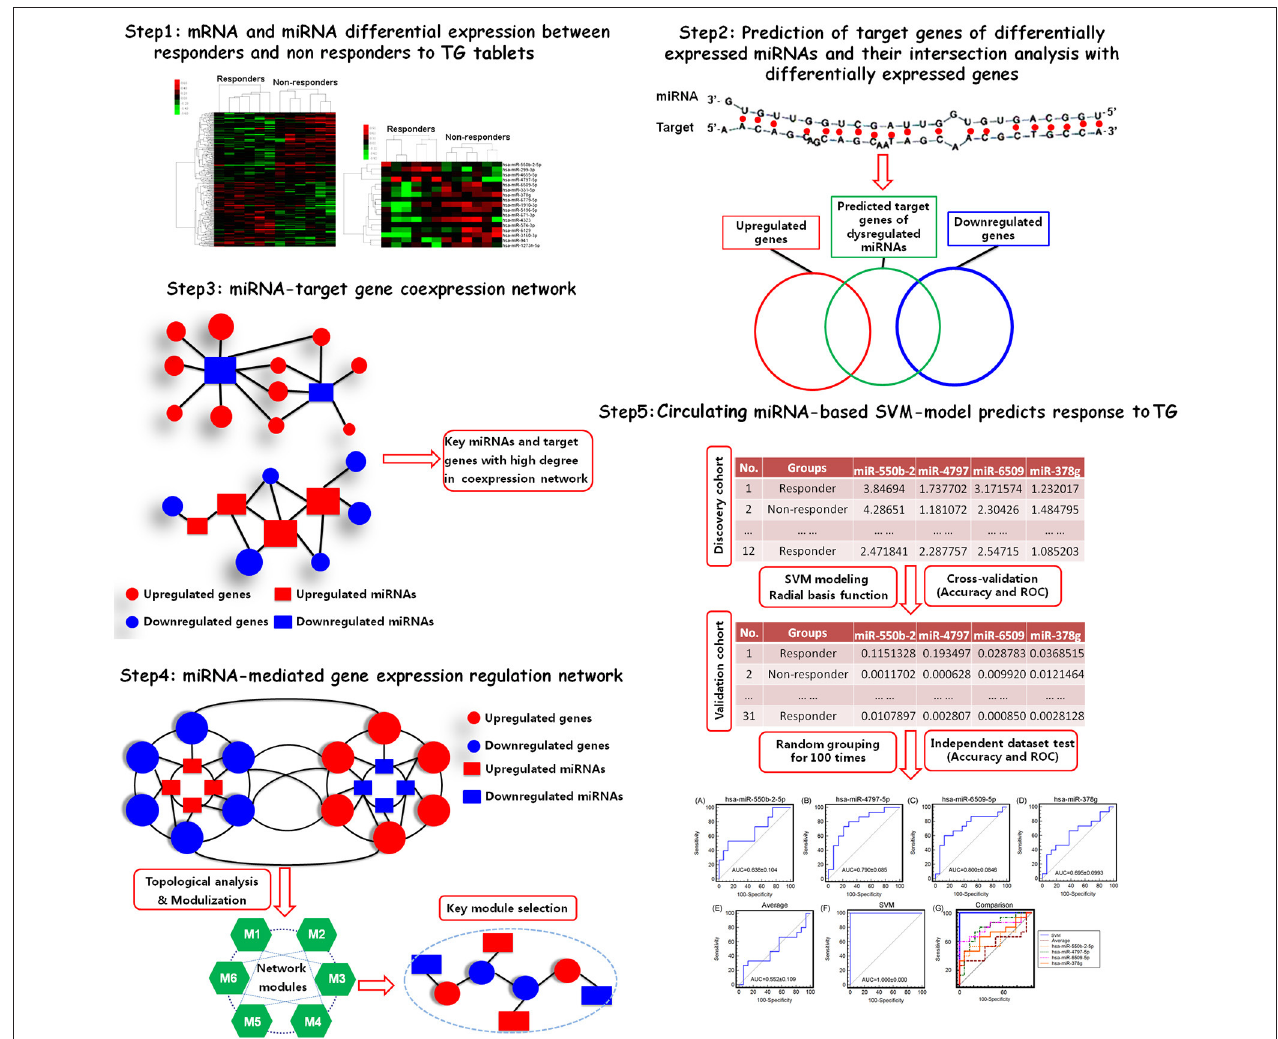
FIGURE 1 | A schematic diagram of the systematic strategies to identify circulating miRNA biomarkers and to construct SVM-based model that predictive of response to TG